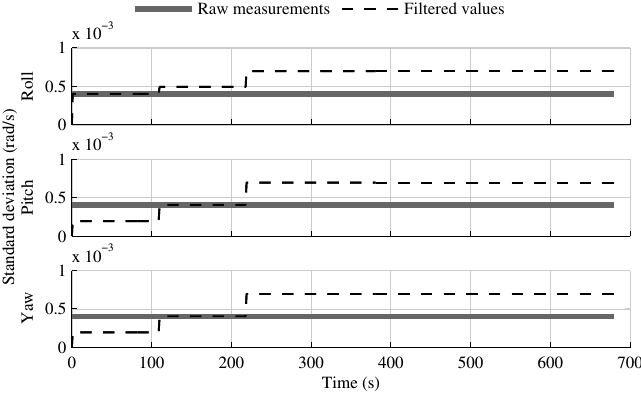
Figure 22. The raw gyroscope measurement standard deviation and the standard deviation of the angular velocity estimated in the fusion of all IMU into one INS, when the attitude reference sensor and GPS receiver are present.